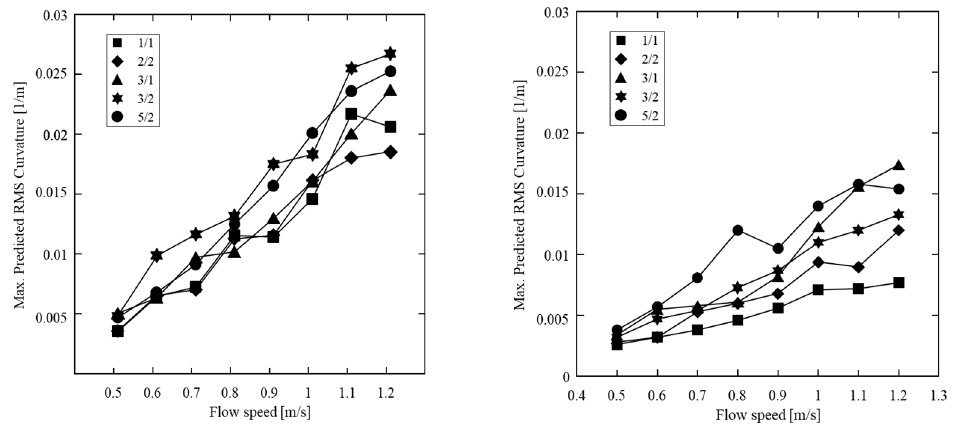
Figure 9. Curvature RMS values for five configurations at flow speeds between 0.5–1.2 m/s. ( Left ): prediction using the default set of excitation coefficients from VIVANA; ( Right ): measured curvature from Shell Test.